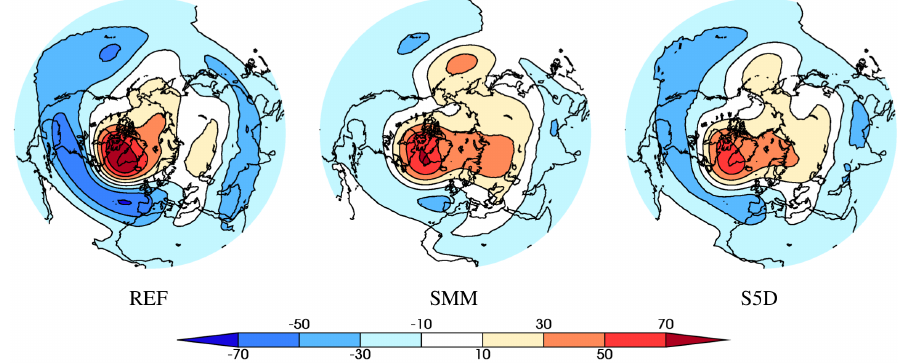
Figure 6. Mean bias for DJF 500hPa geopotential height with respect to ERA-Interim (in m) over the Northern Hemisphere for experiments (from left to right) REF, SMM, and